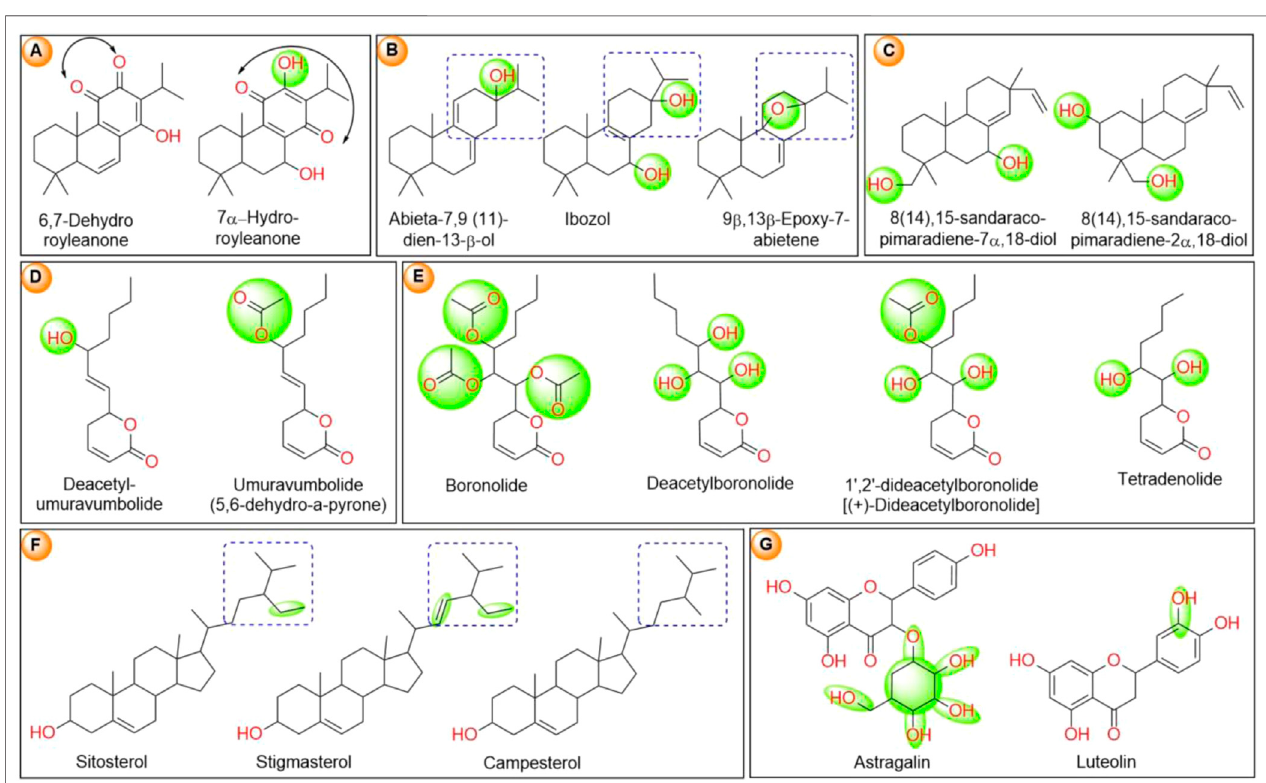
FIGURE9|(A – G) .Structure-activityrelationshipanalysisamongphytochemicalsreportedfrom T.riparia withrespecttobiologicalactivity intheformofgenerated docking score. The chemical structures are presented with the ChemDraw 18.0